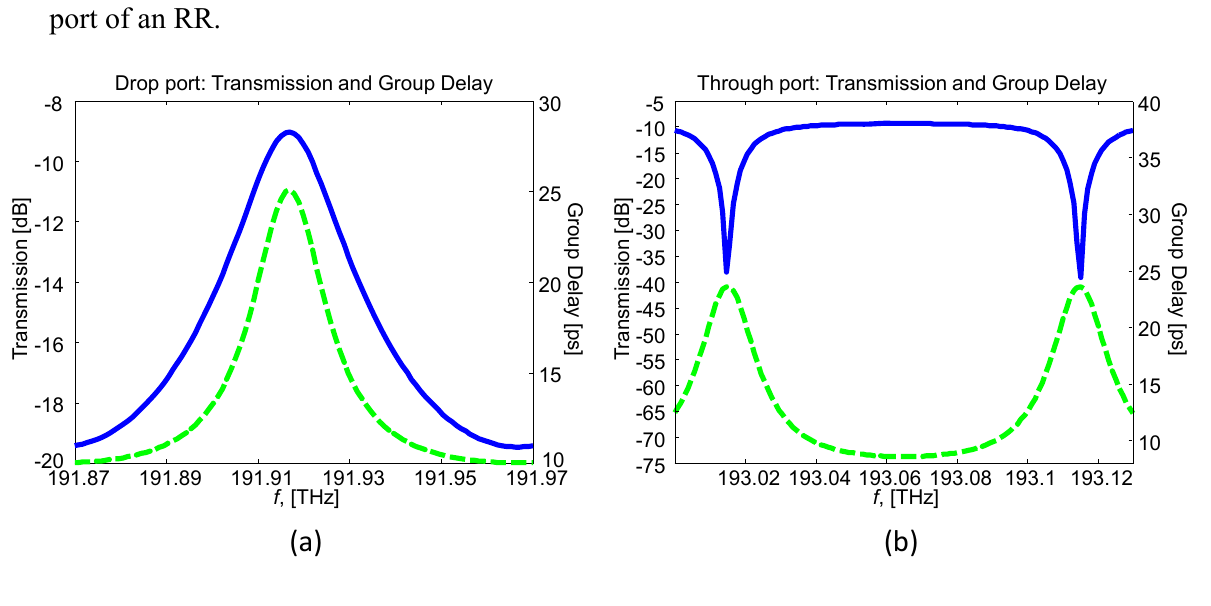
Figure 5. Transfer function “-” and group delay “- -” at the ( a ) drop port and ( b ) through port of an